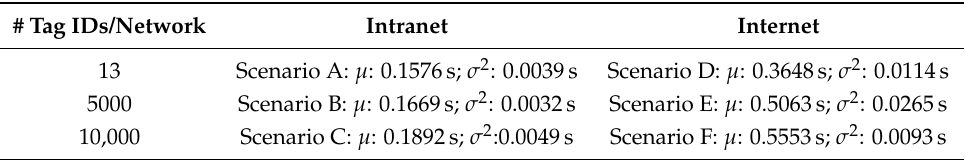
Table 5. Mean and variance of the use cases considered in the OrbitDB performance